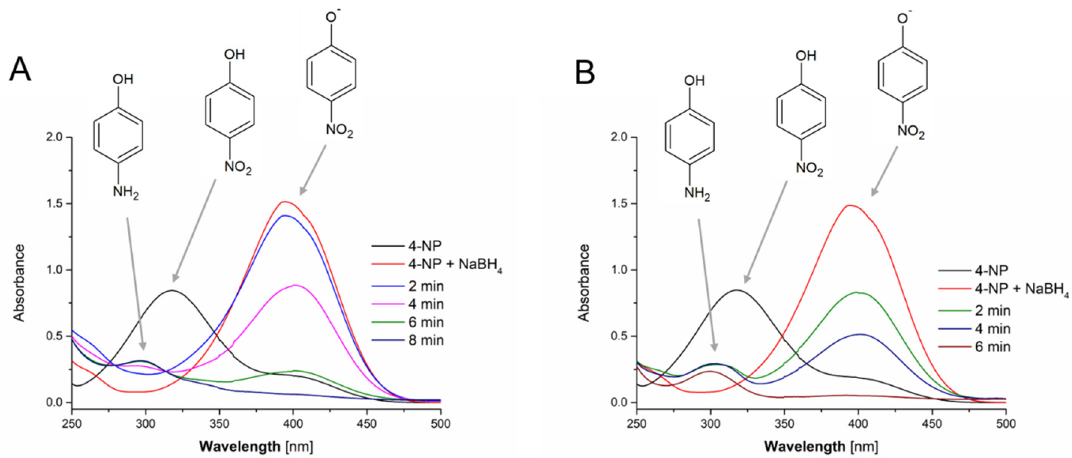
Figure 7. UV / Vis absorption spectra of the catalytic reactions carried out using AuNPs fabricated by ( A ) the aqueous G. biloba leaves extract and ( B ) the aqueous P. ginseng root extract, both activated by FLC-dc-APGD.